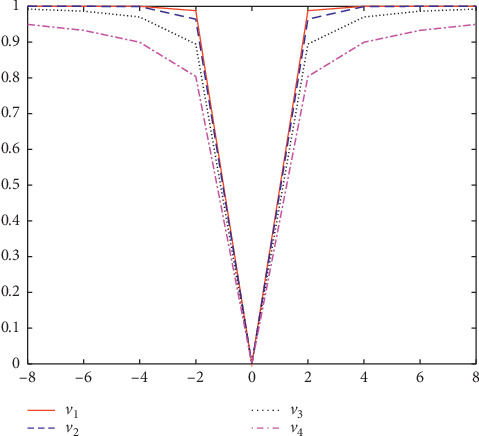
V-shaped transfer functions.